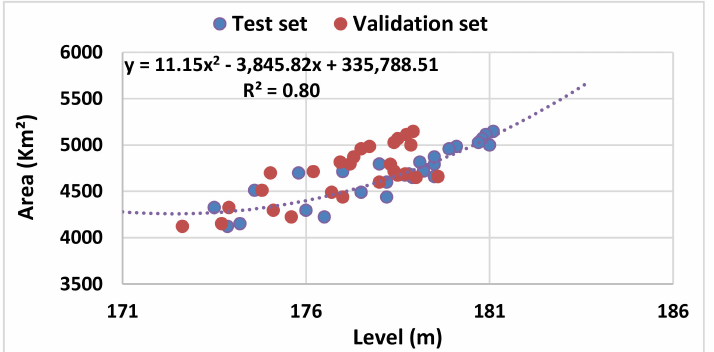
Figure 11. Scatter plot of the altimetry level and in situ level with corresponding Sentinel-3 derived water areas on the y-axis.